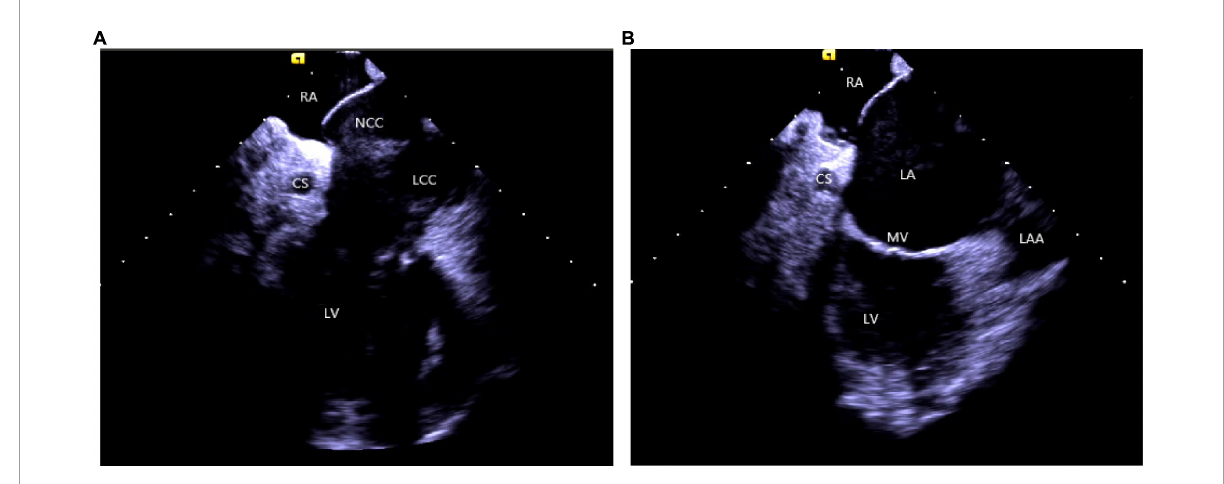
FIGURE2 (A) The clockwise rotation from the HomeView position. (B) The clockwise rotation from the A position. RA, right atrium; CS, coronary cusp; LV, left ventricle; NCC, non-coronary cusp; LCC, left coronary cusp; RVOT, right ventricular outflow tract; LA, left atrium; MV, mitral Valve; LAA, left atrial